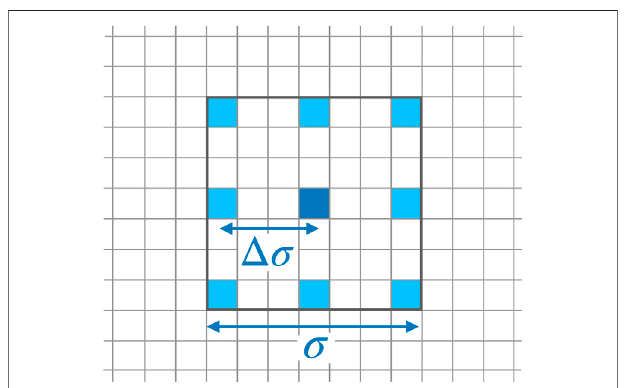
FIGURE 5 | Stencil for locally sampling data used as input of the ESN operating at the location of the dark blue pixel in the center. The stencil is characterized by its width σ and the spatial separation Δ σ of sampling points.